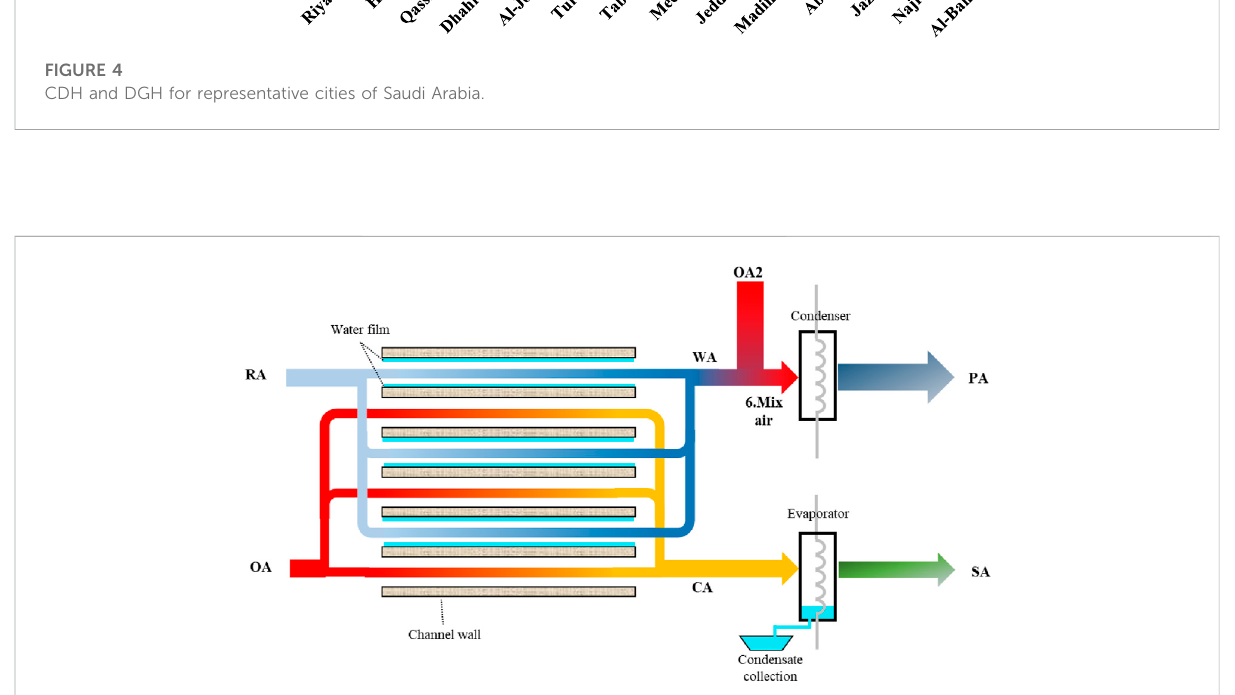
FIGURE 5 Annual weather data for representative cities of four